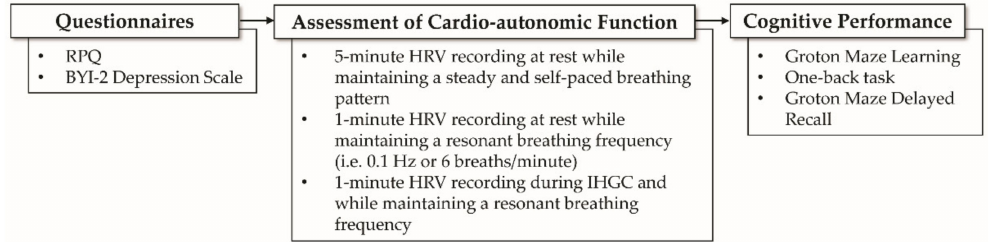
Figure 2. Visual representation of testing evaluation. Abbreviations: RPQ, Rivermead post-concussion symptoms question- naire; BYI-2, Beck Youth Inventories—Second Edition; HRV, heart rate